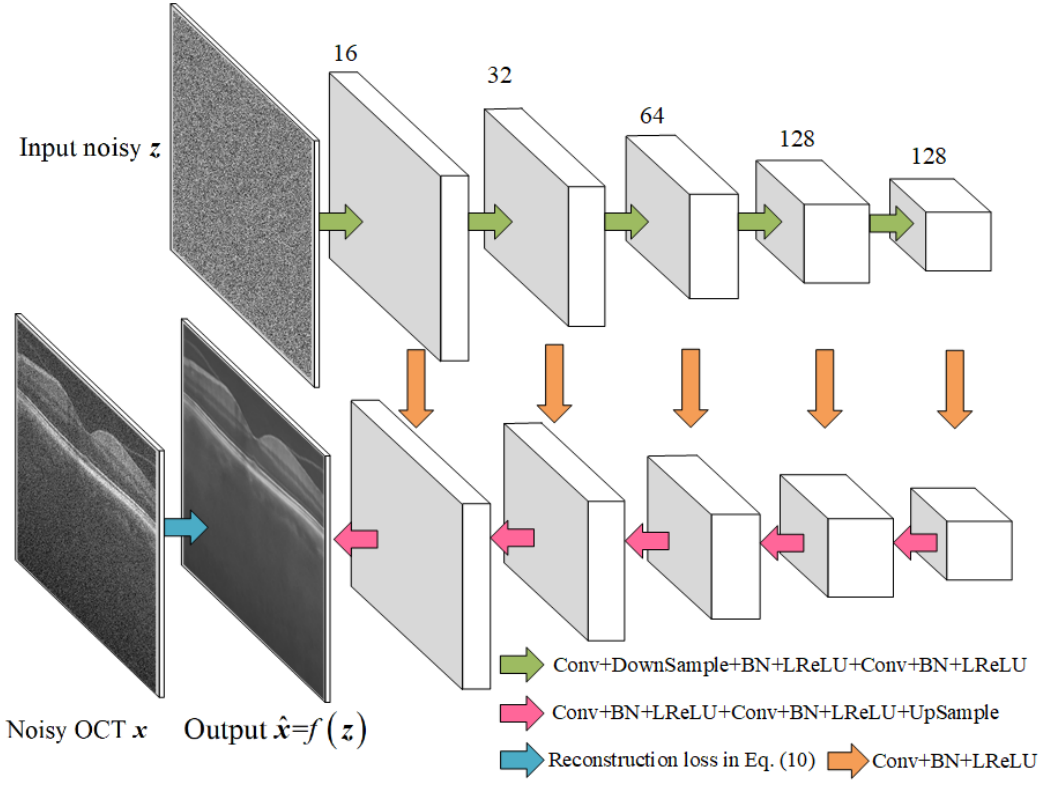
Figure 3. The network structure used in this work.